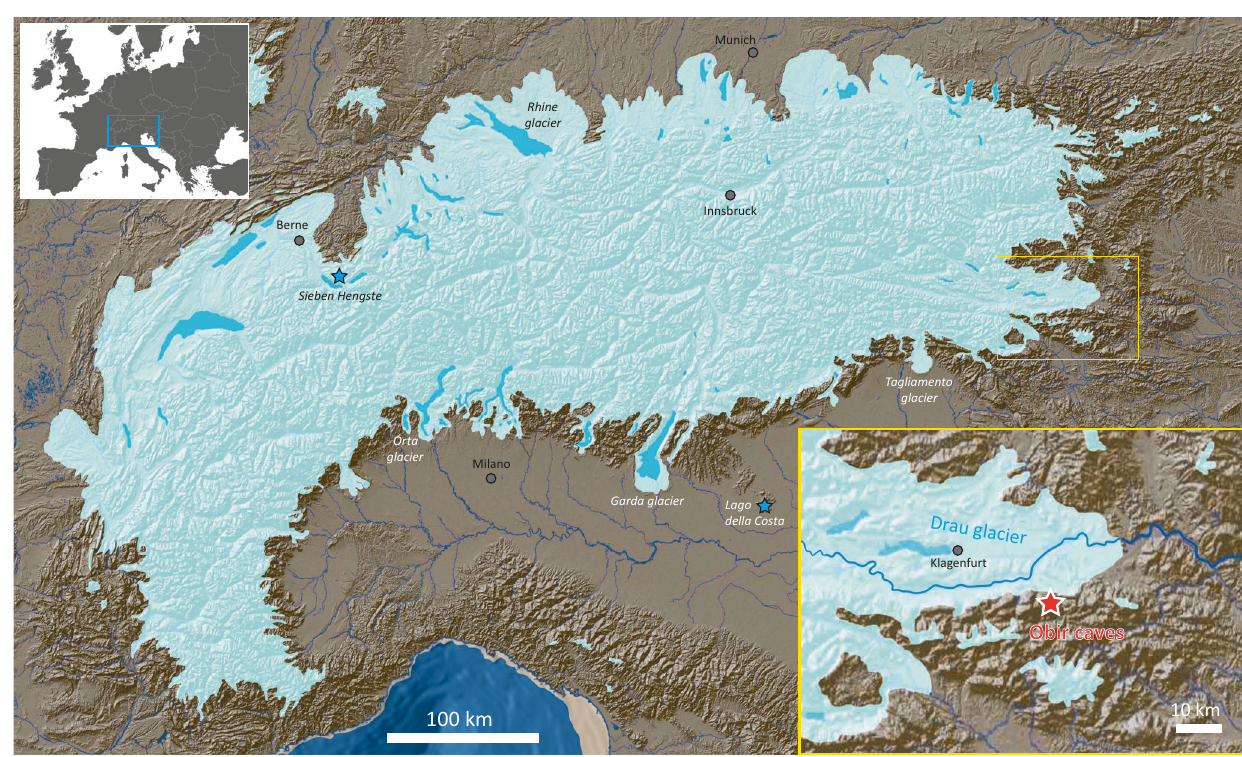
Fig. 1 Relief map of the Alps showing the maximum extent of the Alpine Last Glacial Maximum ice-stream network. The study area of the Obir caves in southeastern Austria is enlarged (yellow rectangle). Other locations mentioned in the text are also labeled. Nunataks are omitted for clarity. Source of base map: © Geologische Bundesanstalt 64